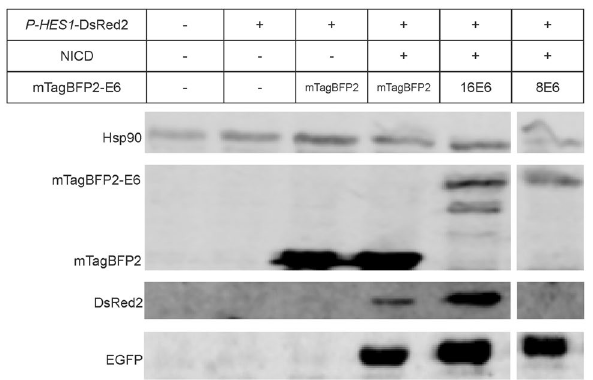
Figure 7. Expression of proteins by Western blot analysis. Expression level of mTagBFP2-E6, DsRed2, and EGFP were assessed by loading 70 µg of total proteins on reducing 8–20% SDS-PAGE gel. HSP90 serves as a loading control. DsRed2 protein signal is increased for 16E6 but absent for 8E6. In line with the FACS assay, these results indicate an activation by 16E6 and a repression for 8E6 of the Notch pathway. Please find full blot and detailed blot information in Figure